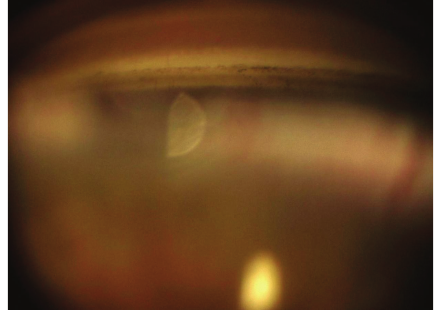
Figure4:Gonioscopyofthelefteyeshowswideopenchamberangle and with mild